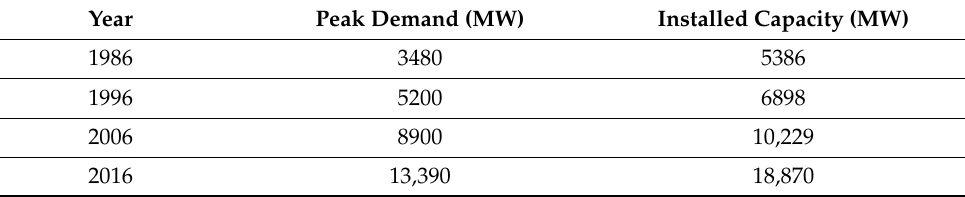
Table 1. State of Kuwait power generation demand and supply for the period 1986–2016. Source: MEW